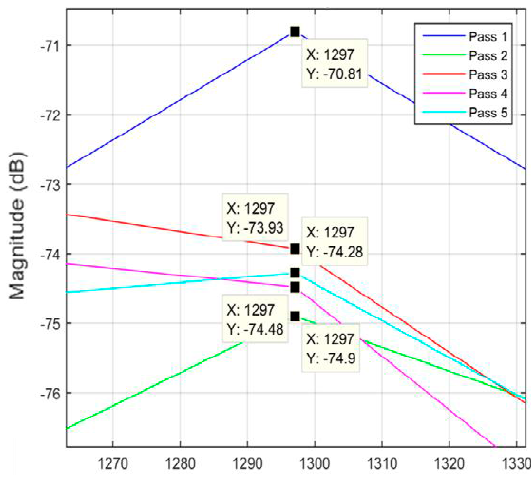
Figure 15. Vibration signal in Y direction. Table 2. Skewness, kurtosis and RMS of vibration signal from 3-axes accelerometer.